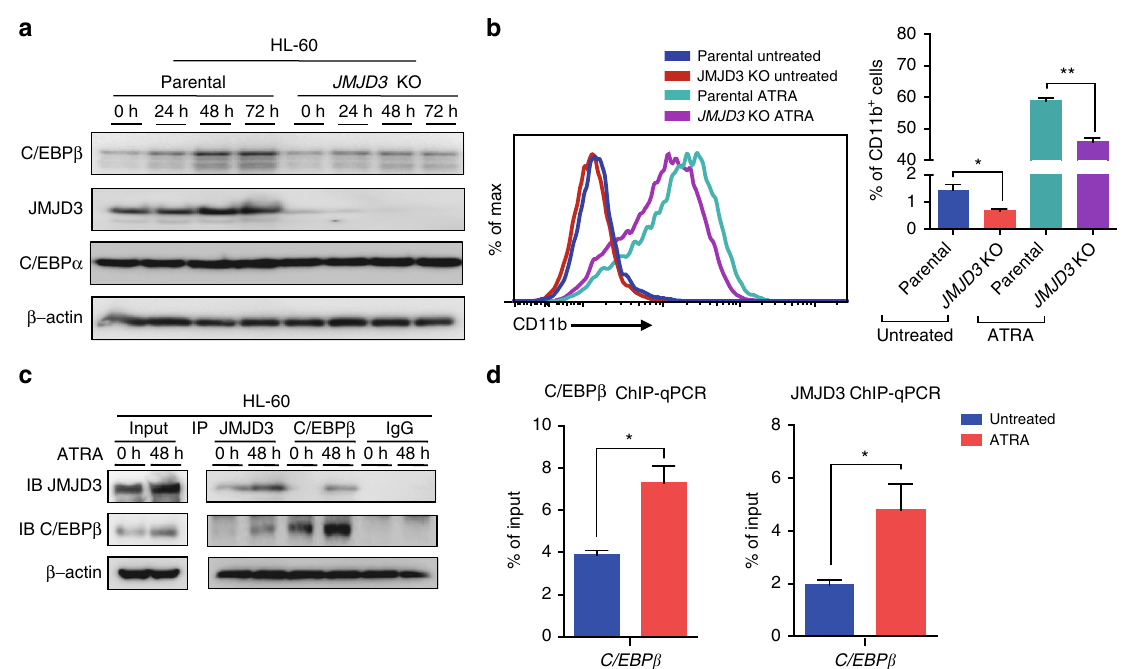
Fig. 7 C/EBP β /JMJD3 induction participates in ATRA-induced myeloid differentiation of AML cells. a HL-60 cells were treated with 1 µ M ATRA for the indicated times. The protein levels of C/EBP β , JMJD3, and C/EBP α were measured by western blotting, and β -actin was used as a loading control. b Flow cytometric analyses of CD11b expression of HL-60 parental cells or JMJD3 knockout HL-60 cells treated with or without 1 µ M ATRA for 48 h. c Hl-60 cells were treated with 1 µ M ATRA for 48 h. Cell lysates were then co-immunoprecipitated with JMJD3 antibody, C/EBP β antibody or control IgG, to be followed by immunoblot with anti-C/EBP β or anti-JMJD3 antibody as indicated. d ChIP – qPCR for JMJD3 or C/EBP β occupancy at the C/EBP β gene locus for HL-60 cells treated with or without 1 µ M ATRA for 24 h. Data are shown as the mean ± SEM; * p < 0.05, ** p <